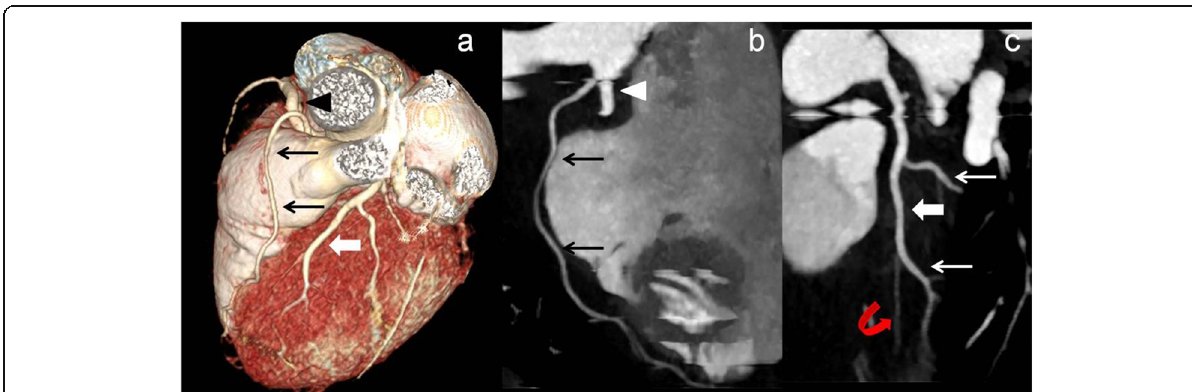
Fig. 5 a Volume rendered (VRT) CT angiography images showing a long LAD with a pre-pulmonic course (black arrows) and a short LAD (white arrow) giving rise to first and second diagonal branches. b Maximum intensity projection (MIP) curved reformatted CT angiography image showing long LAD (black arrow) continuing till apex. c MIP image showing short LAD ( thick arrow) entering the AIS and giving rise to first and second diagonal branches (thin white arrows). Small caliber distal LAD terminating just before reaching the apex